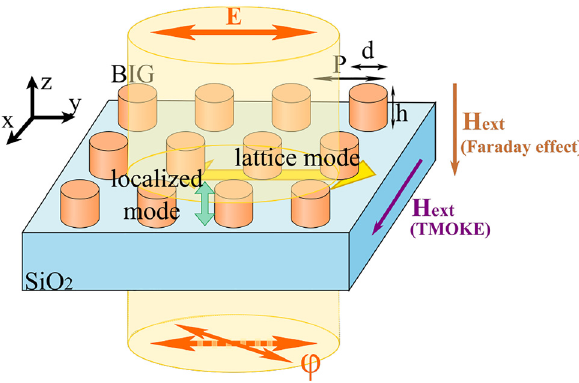
Figure 1: Schematic representation of the BIG nanocylinder 2D array and the excited localized and lattice